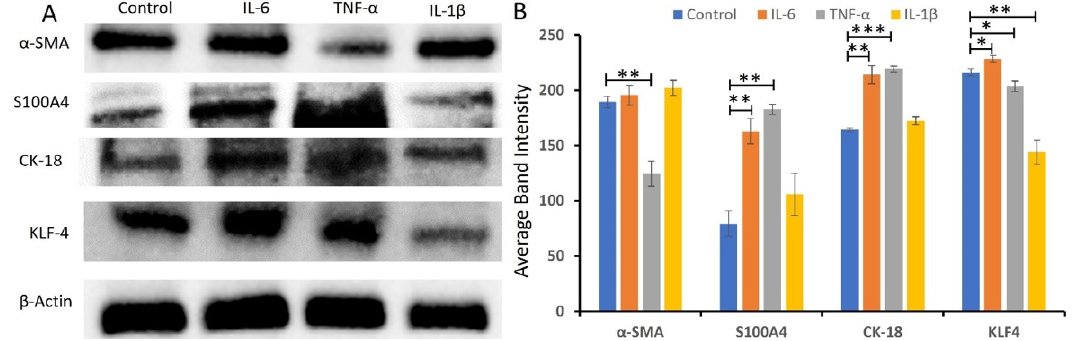
Figure 6. Western blot analyses of the effects of inflammatory cytokines on VSMCs phenotype markers. Panel ( A )—Western blot images of VSMC markers; Panel ( B )—percent changes in protein expression compared to control. Control protein was considered as 100% for the analysis. Alpha- smooth muscle actin ( α -SMA), cytokeratin (CK)-18, S100 protein A4 (S100A4), Krüppel-like factor 4 (KLF4), interleukin (IL), and tumor necrosis factor (TNF)- α . * p < 0.05, ** p < 0.01, *** p < 0.001.